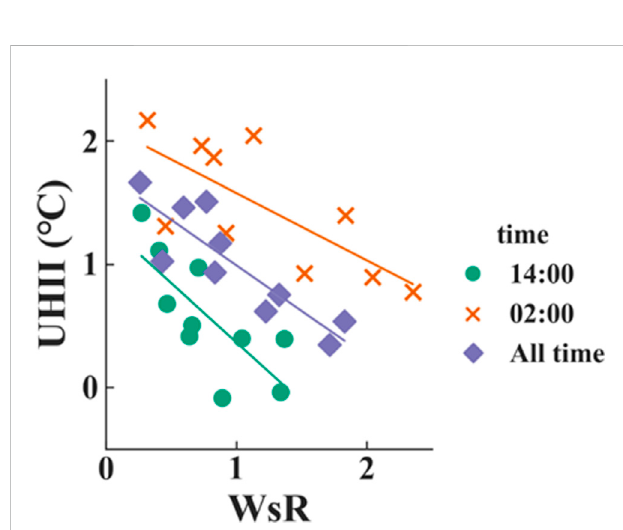
FIGURE 11 Relationship between UHII and WsR at each urban station. The straight line in the fi gure represents the linear trend of each